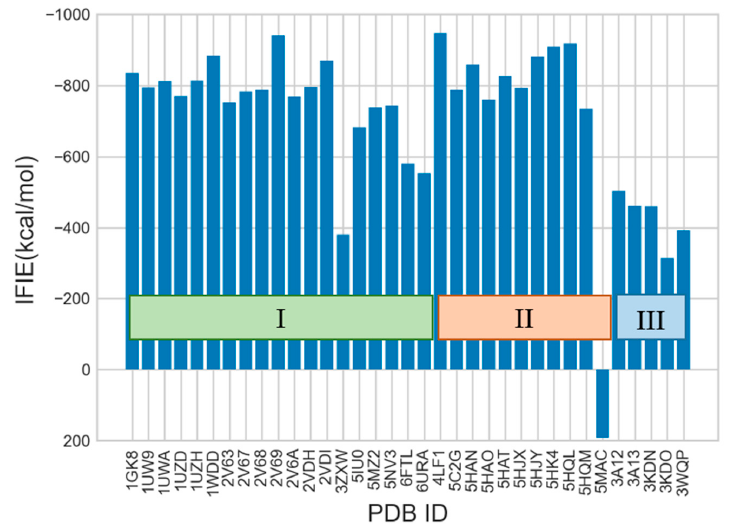
Figure 3. Calculated results of IFIE-sum for 2CABP. The PDB structures of 35 RuBisCOs are grouped into three isoforms I–III. into three isoforms